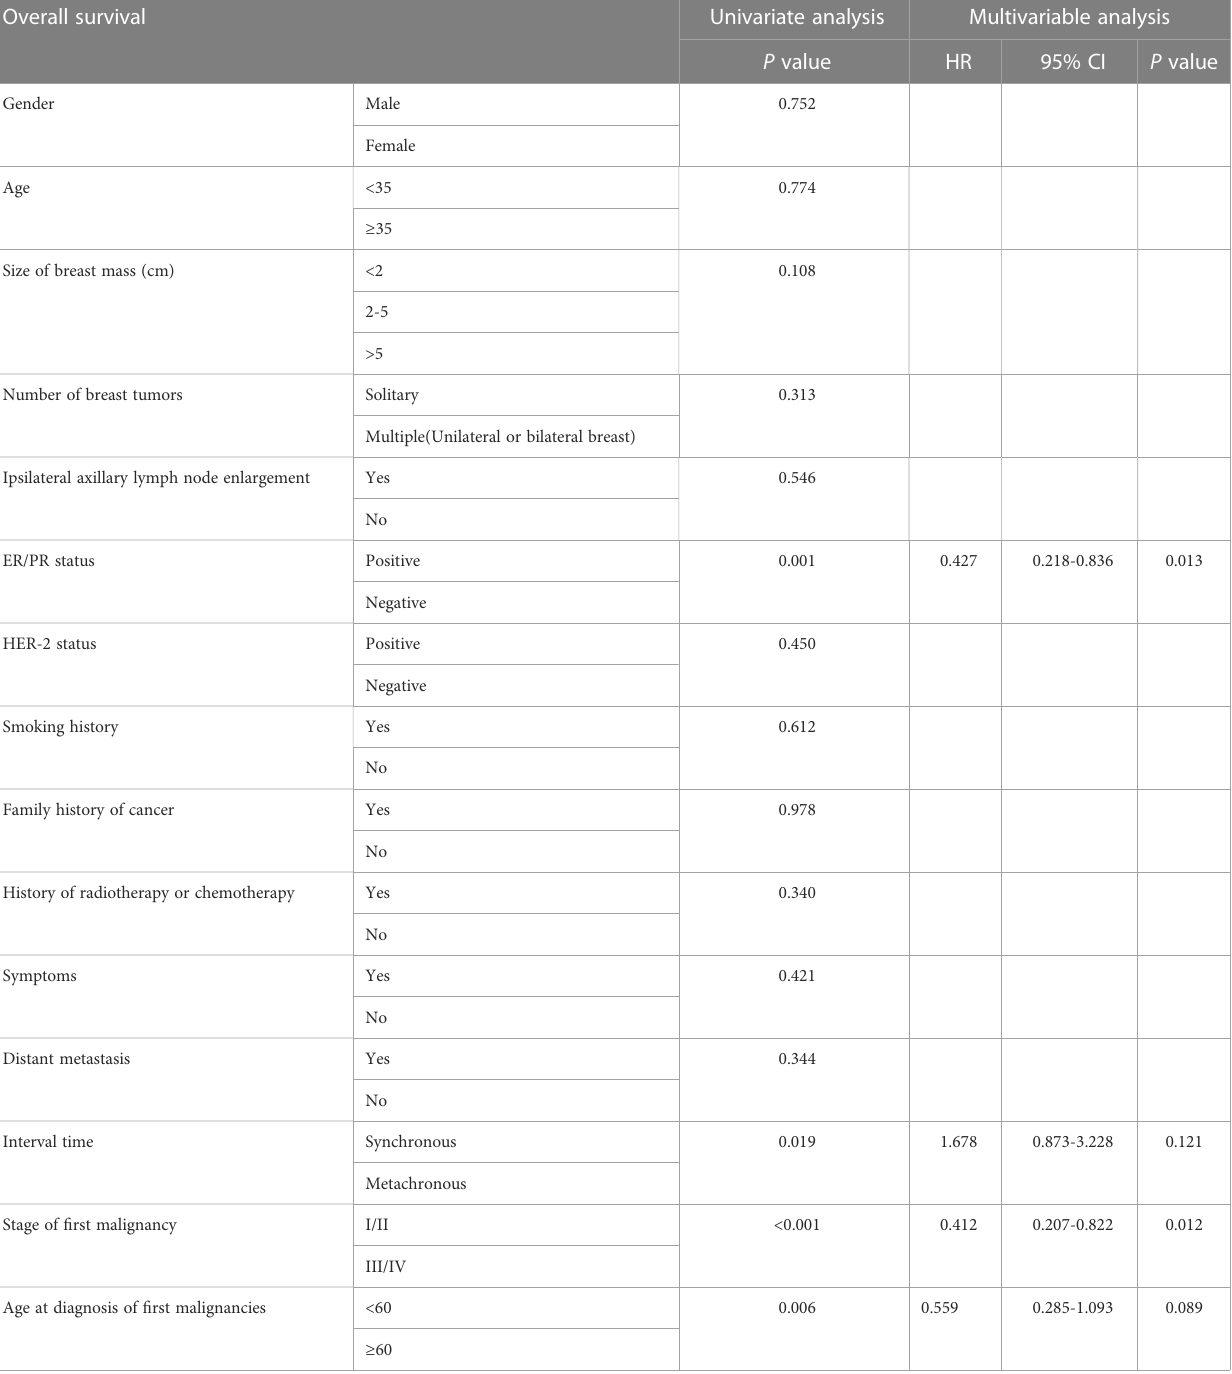
TABLE 4 Univariate survival analysis and multivariable analysis of patients with second primary breast